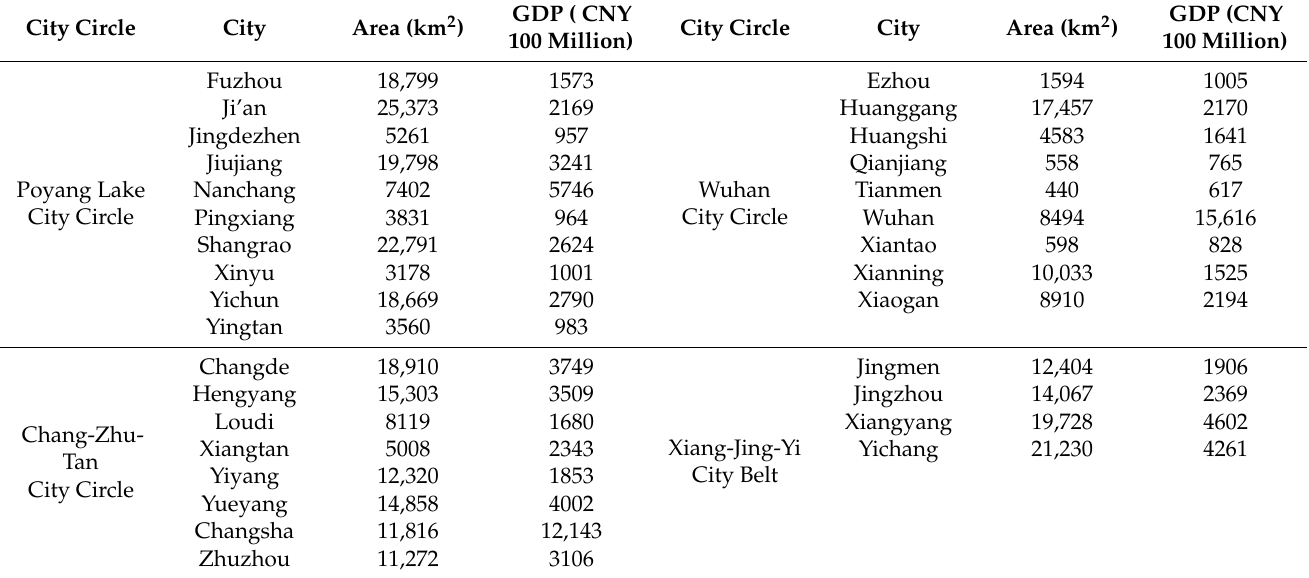
Table 1. List of cities of